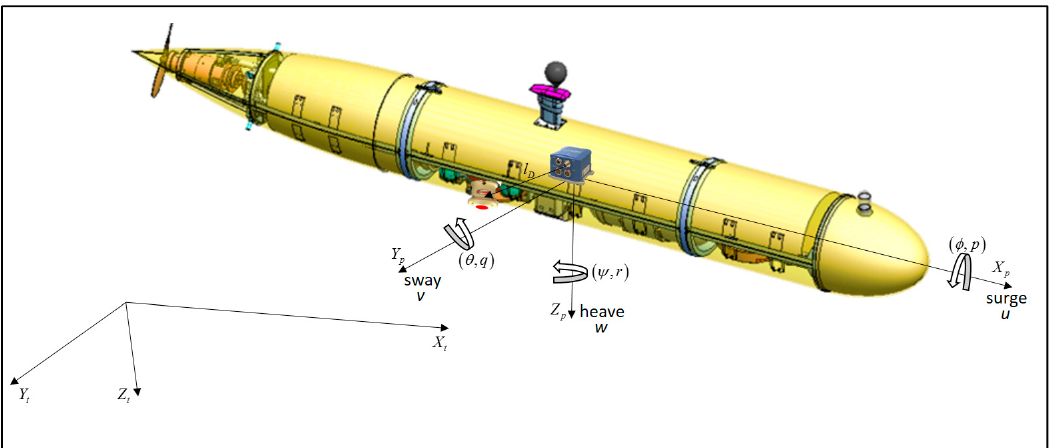
Figure 4. Platform frame and tangent frame in respect to the TAUV.